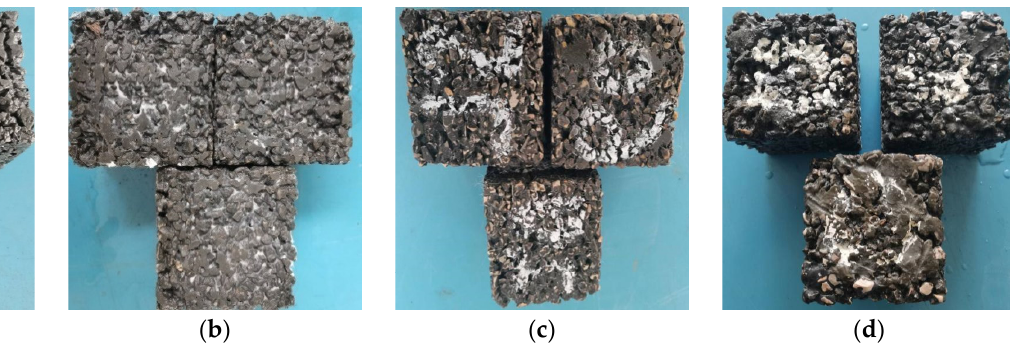
Figure 14. The testing phenomenon of specimens (with basalt fiber content of 4 kg/m 3 ) for acidic corrosion: ( a ) 0 day, ( b ) 20 days, ( c ) 40 days, and ( d ) 60 days.